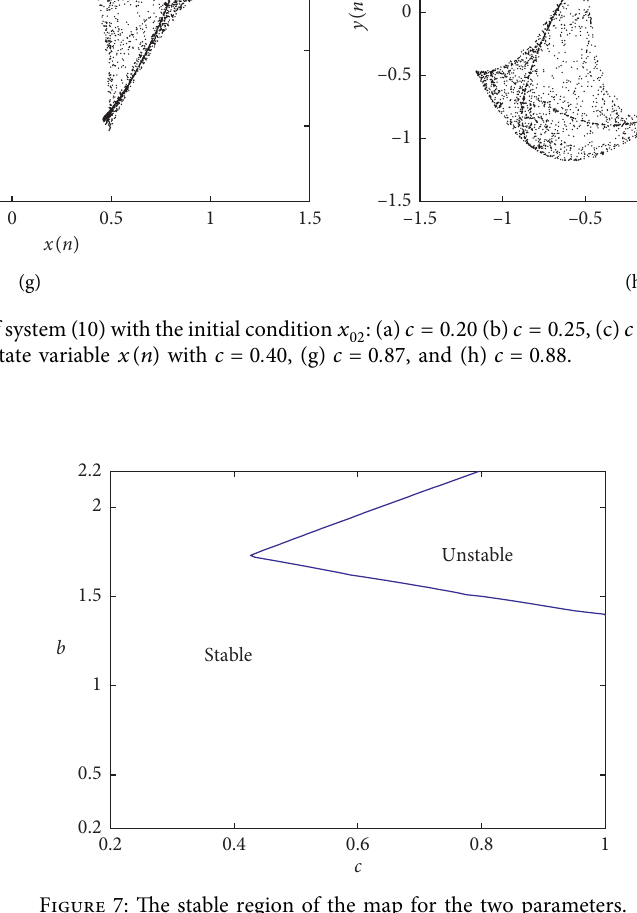
Figure 7: The stable region of the map for the two parameters.